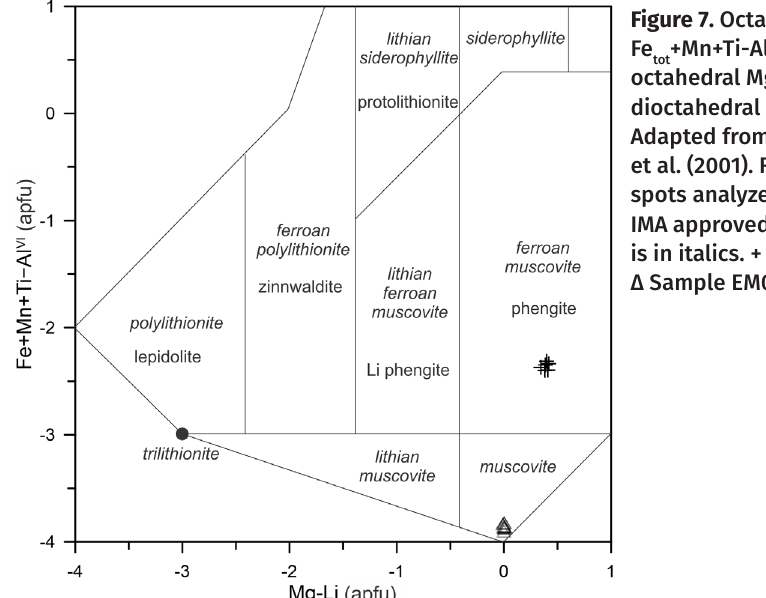
spots analyzed by